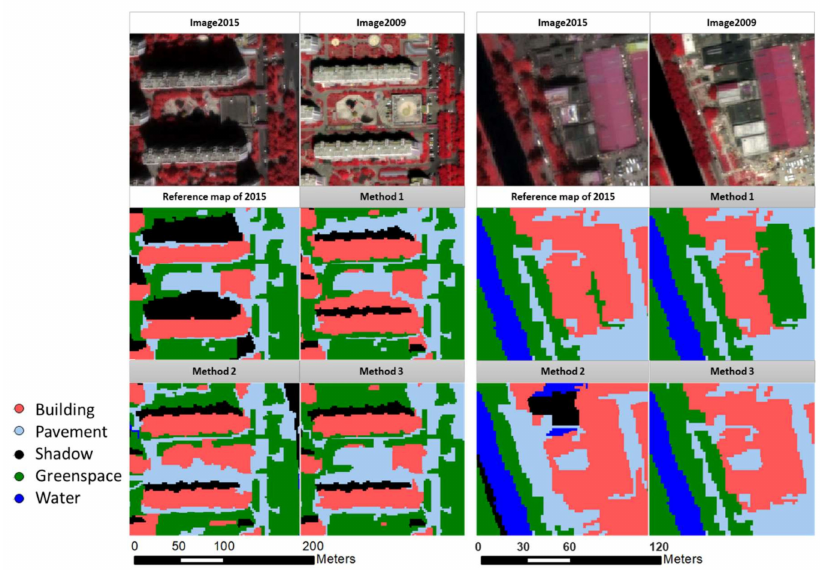
Figure 8. The zoom-in of classification results of the three methods. We highlighted the classification results in 2009 in gray.